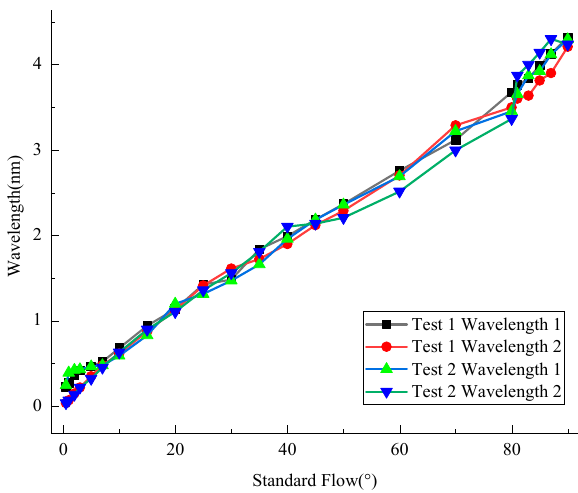
Figure 21. Wavelength increment and flow direction.